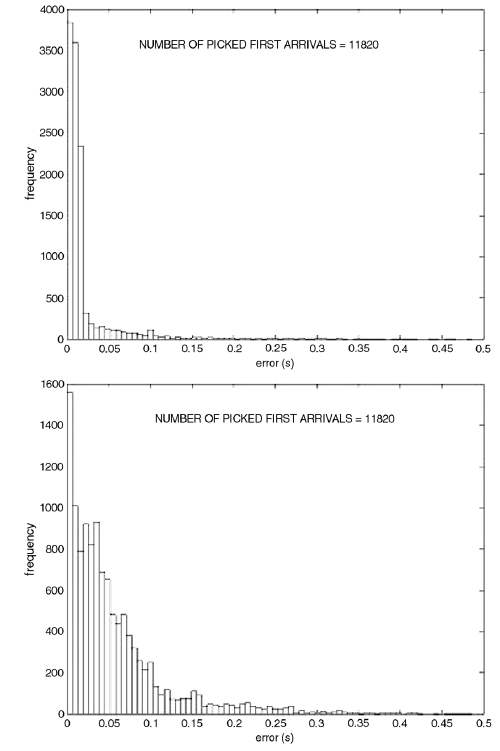
Fig. 6. Frequency distributions of the picked-travel times errors: Hilbert Transform method (upper) and statistical method